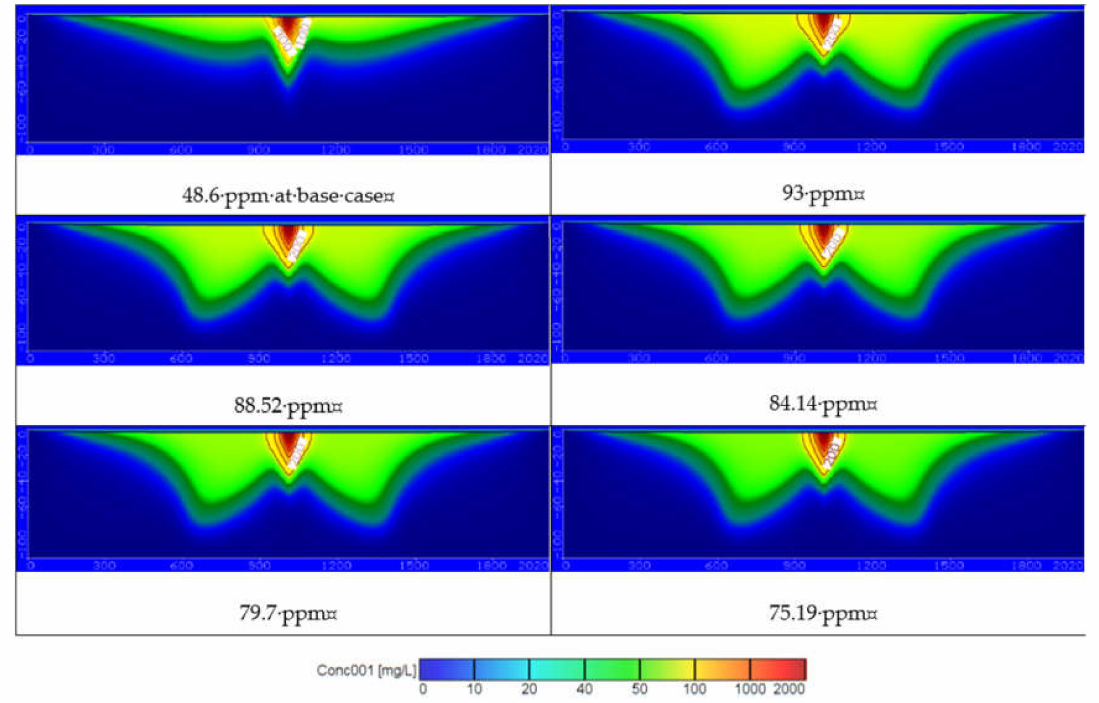
Figure 9. The distribution of COD in groundwater contamination for using different rates of treated wastewater recharge